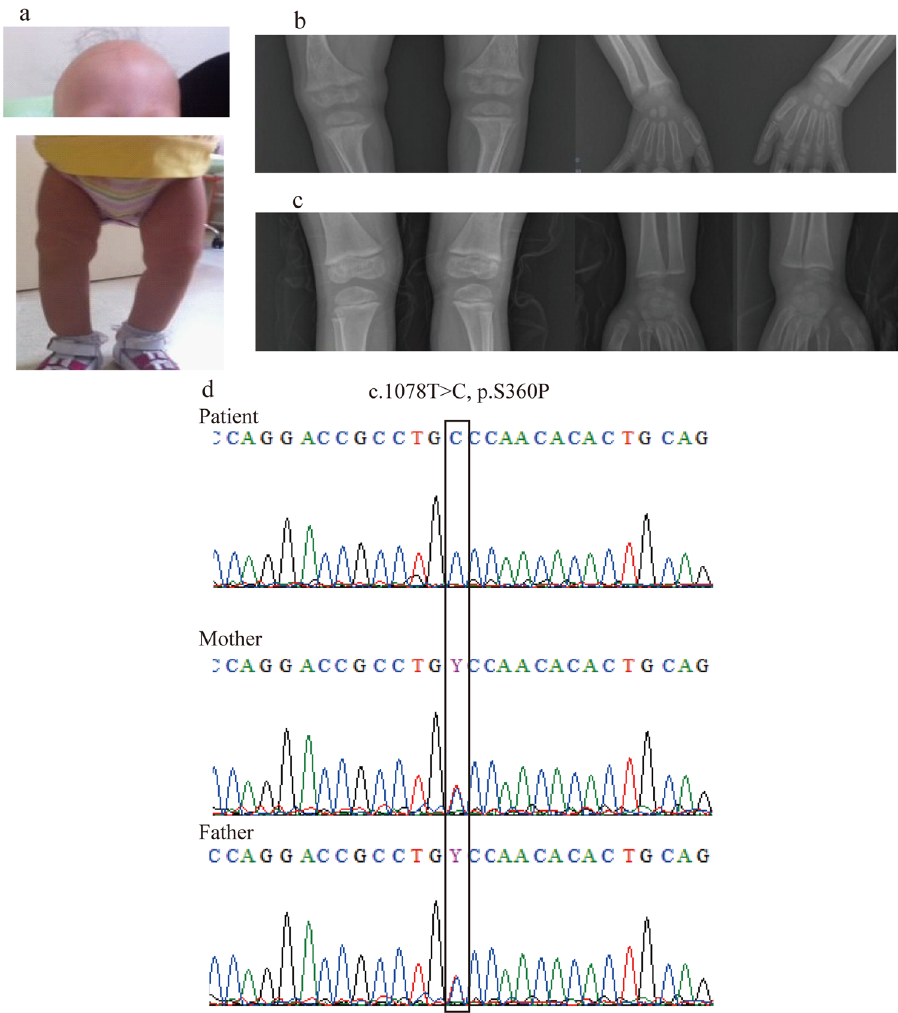
Figure 1. Clinical appearance of the patient and results of VDR gene analysis. ( a ) Pictures of the patient. The patient had almost total alopecia and bowlegs. An X-ray examination of the patient’s legs ( b ) before and ( c ) after 1 year of cinacalcet treatment. ( d ) Results of VDR gene analysis. The patient had a homozygous mutation, c.1078 T > C, p.S360P. Both parents were